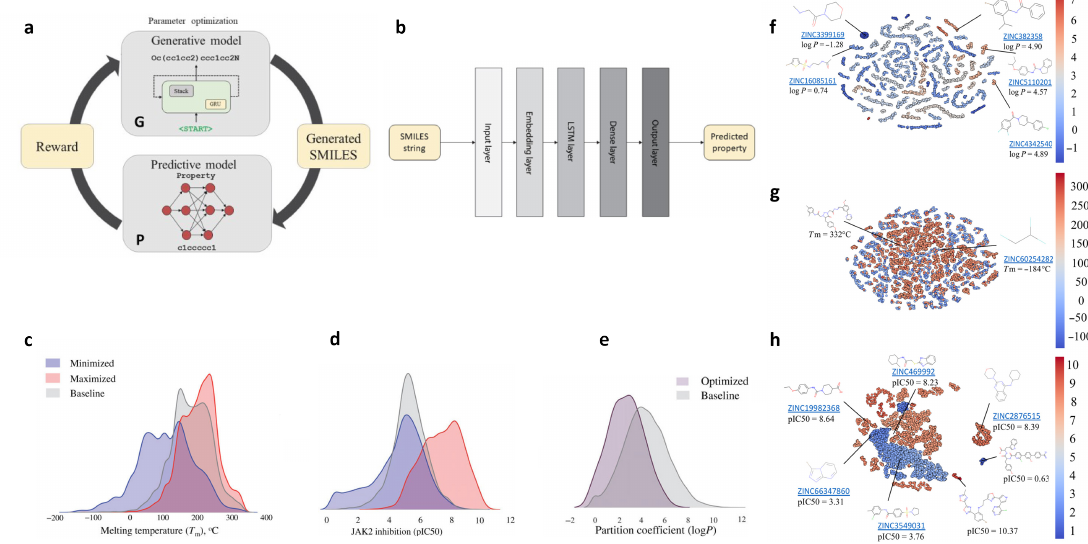
Figure 8. De novo drug-like molecular design framework. ( a ) The proposed framework of reinforcement learning (RL) model; ( b ) flow chart of the predictive model; ( c – e ) properties distributions of RL model versus baseline model (no RL); ( f , g , h ) clustering of generated molecules. The figures are adapted from Reference [116] with permission, copyright 2018